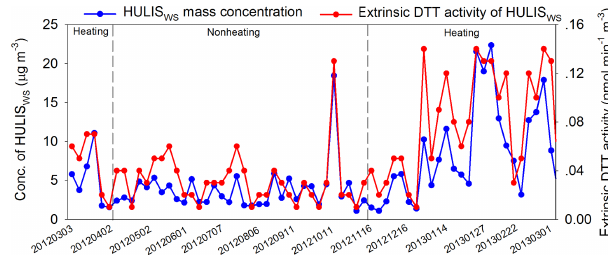
Figure 1. Monthly average concentrations (average ± standard er- ror) of HULIS WS mass concentration and organic matter (OM) in PM 2 . 5 collected in Beijing. The monthly percentage contributions of HULIS WS to OM are shown in the blue line.